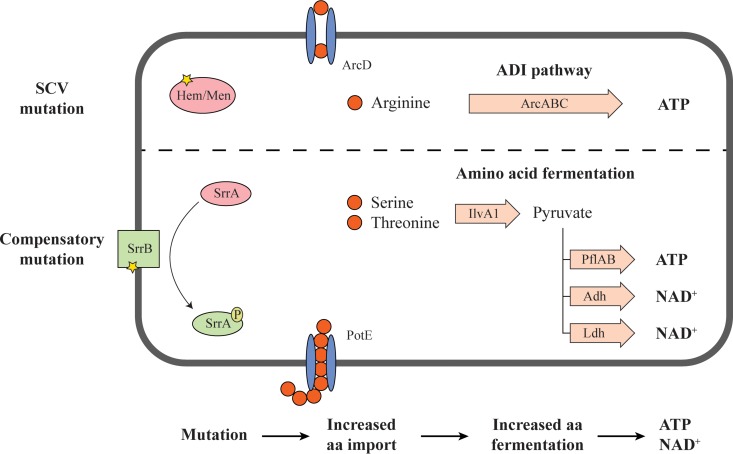
Cellular responses to SCV and transcriptional suppressor mutations. SCV-inducing mutations in the hemin or menadione biosynthesis pathways abolish cellular respiration. As a phenotypic compensation, genes involved in the arginine deiminase (ADI) pathway are upregulated, increasing the production of ATP from arginine to support growth. SCV suppressor mutations in srrAB cause constitutive activation of the SrrAB two-component system, which leads to increased expression of genes involved in peptide transport and in the fermentation of serine and threonine to produce ATP and NAD+.